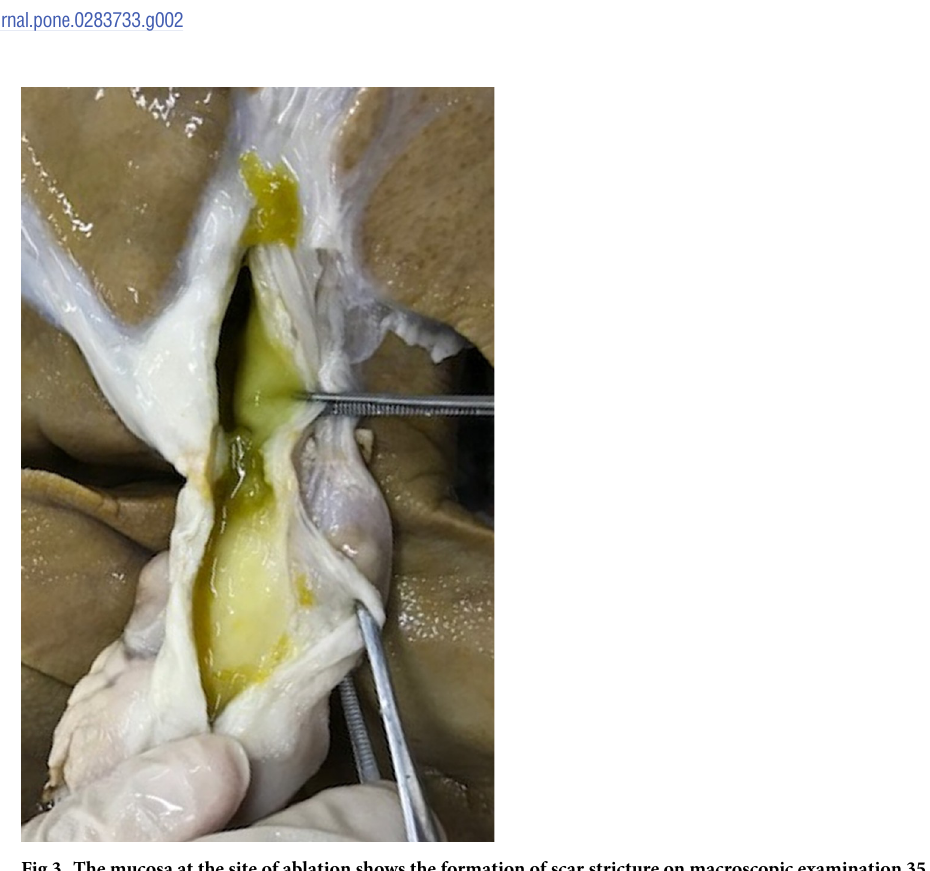
PLOS ONE | https://doi.org/10.1371/journal.pone.0283733 March 31,